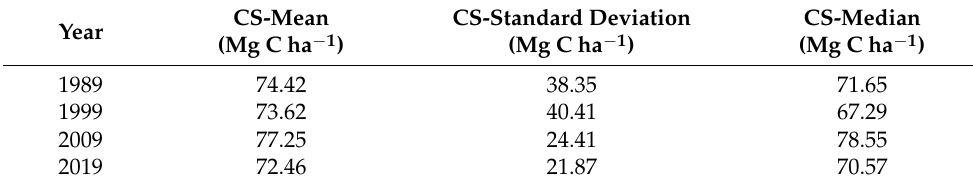
Table 3. Ground survey data statistics.